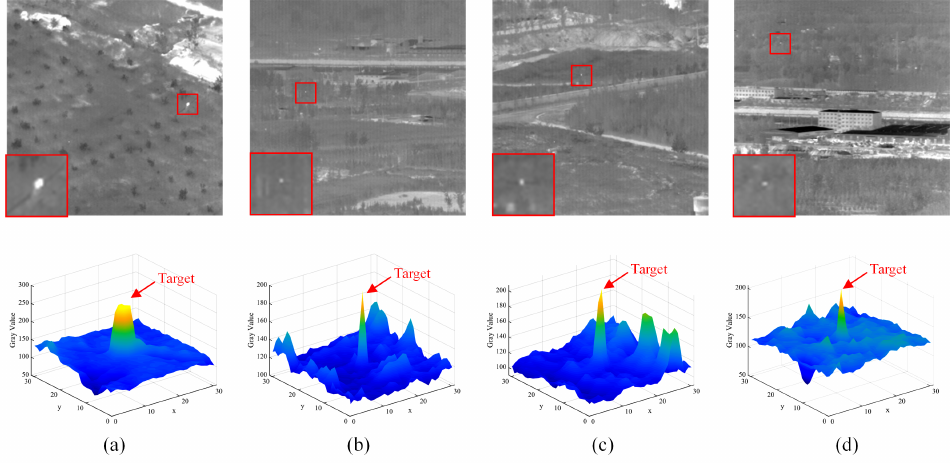
Figure 2. Representative of infrared small targets in various low-altitude scenes. The first row of ( a – d ) shows the original images, and the actual target area (less than 7 × 7pixels) is marked using a red box with a close-up version shown in the bottom-left of each image. The second row of ( a – d ) shows the grayscale distribution (3D-view) of of the local areas containing the